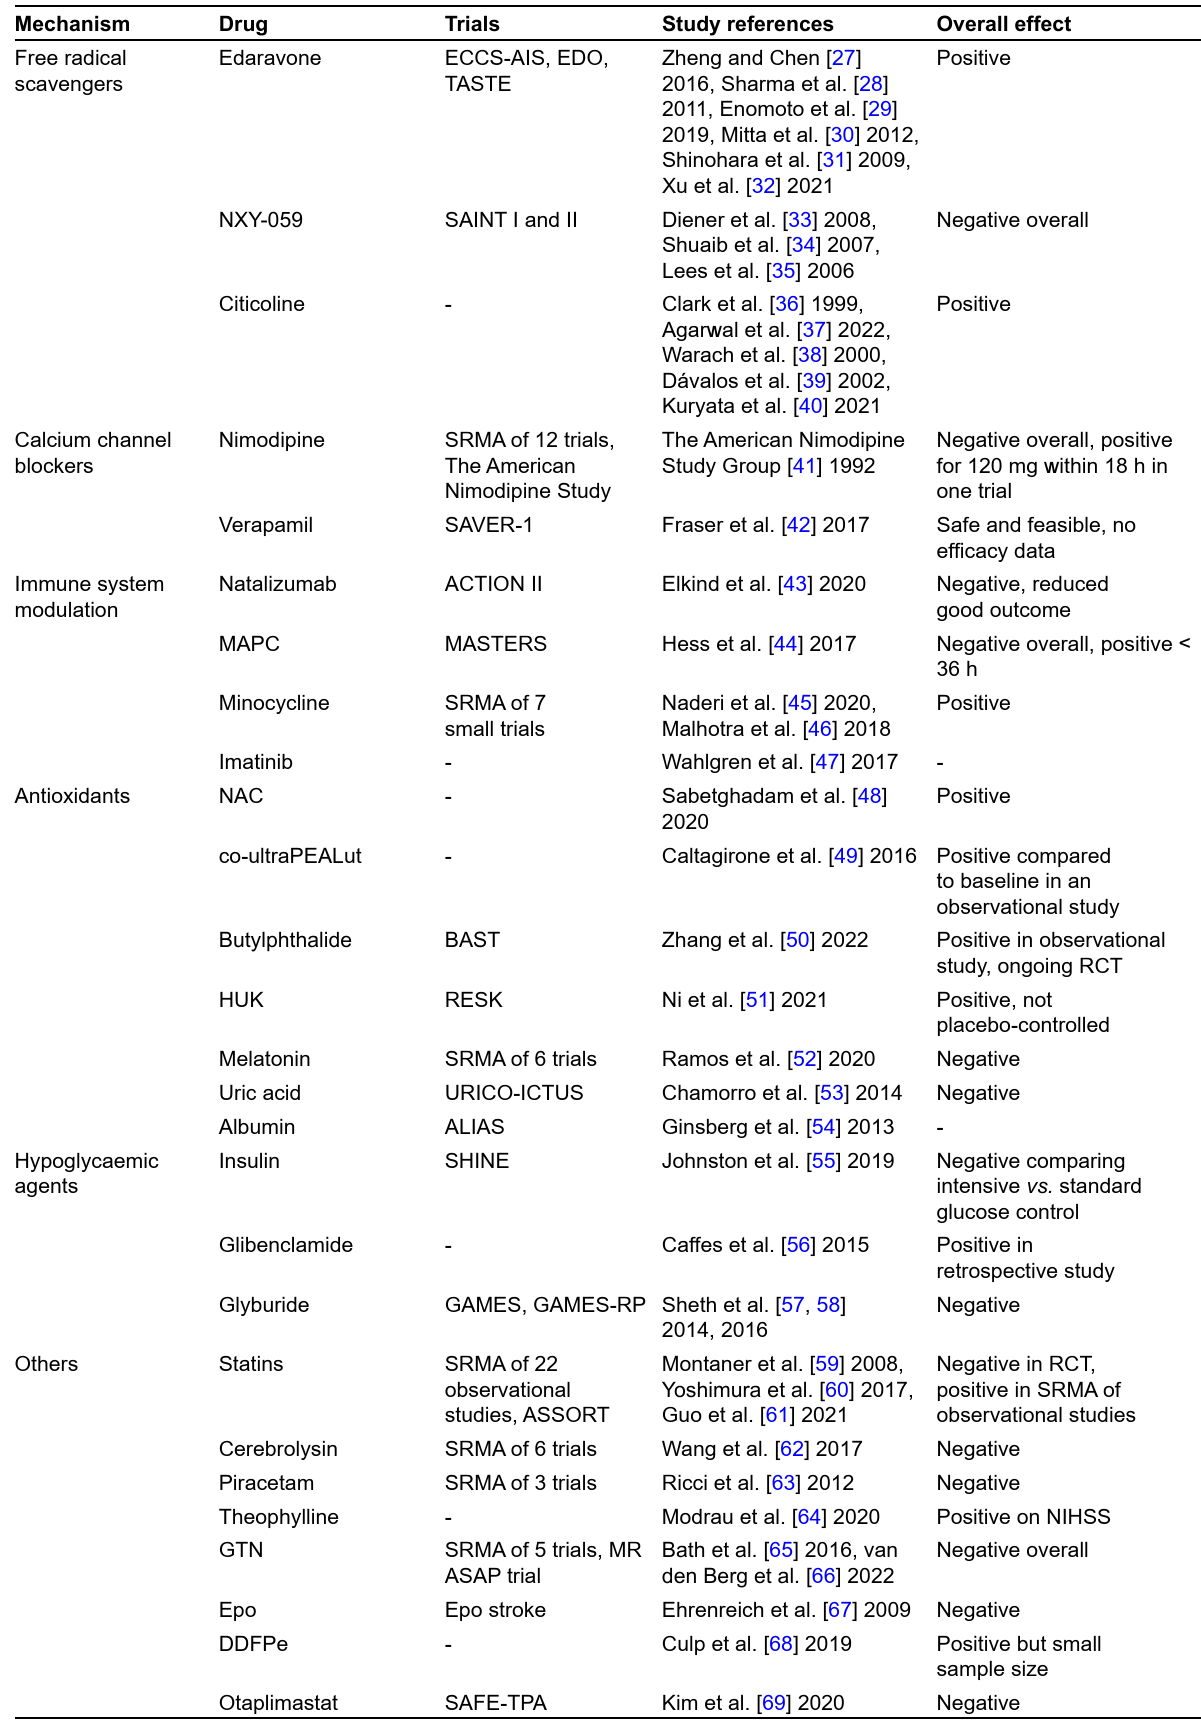
Table 1. Overview of human trials on neuroprotective agents in AIS ( continued )